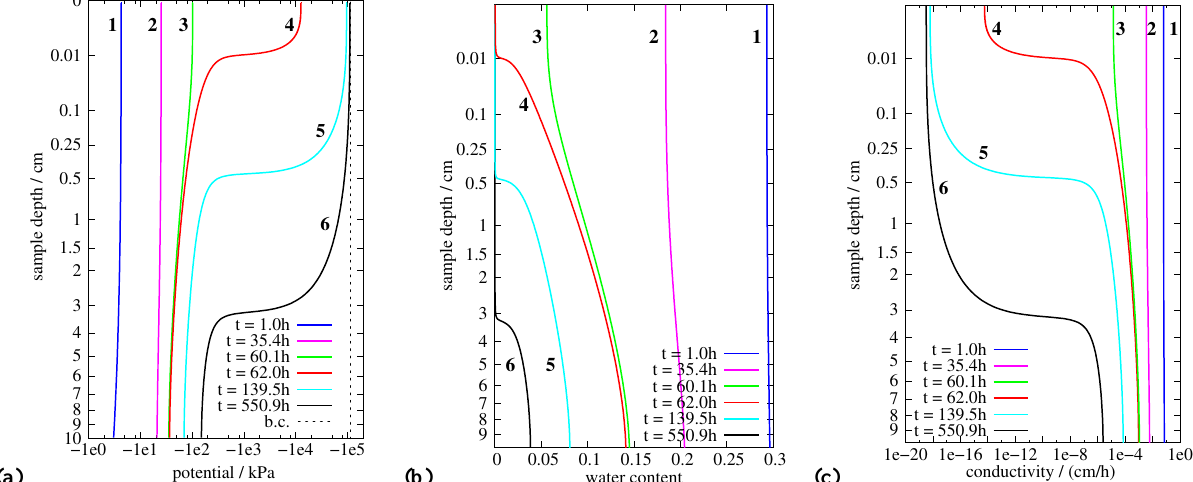
Fig. 4. Potential ψ m (z) (a) , water content θ ‘ (z) (b) and hydraulic conductivity K(θ(z)) (c) distributions for the onestep experiment at different times t i : (1) at an early time in regime I, (3) directly before the transition to regime II, (4) a short time later after the transition, (6) at the end of the experiment. Notice the non-linear scaling of the depth